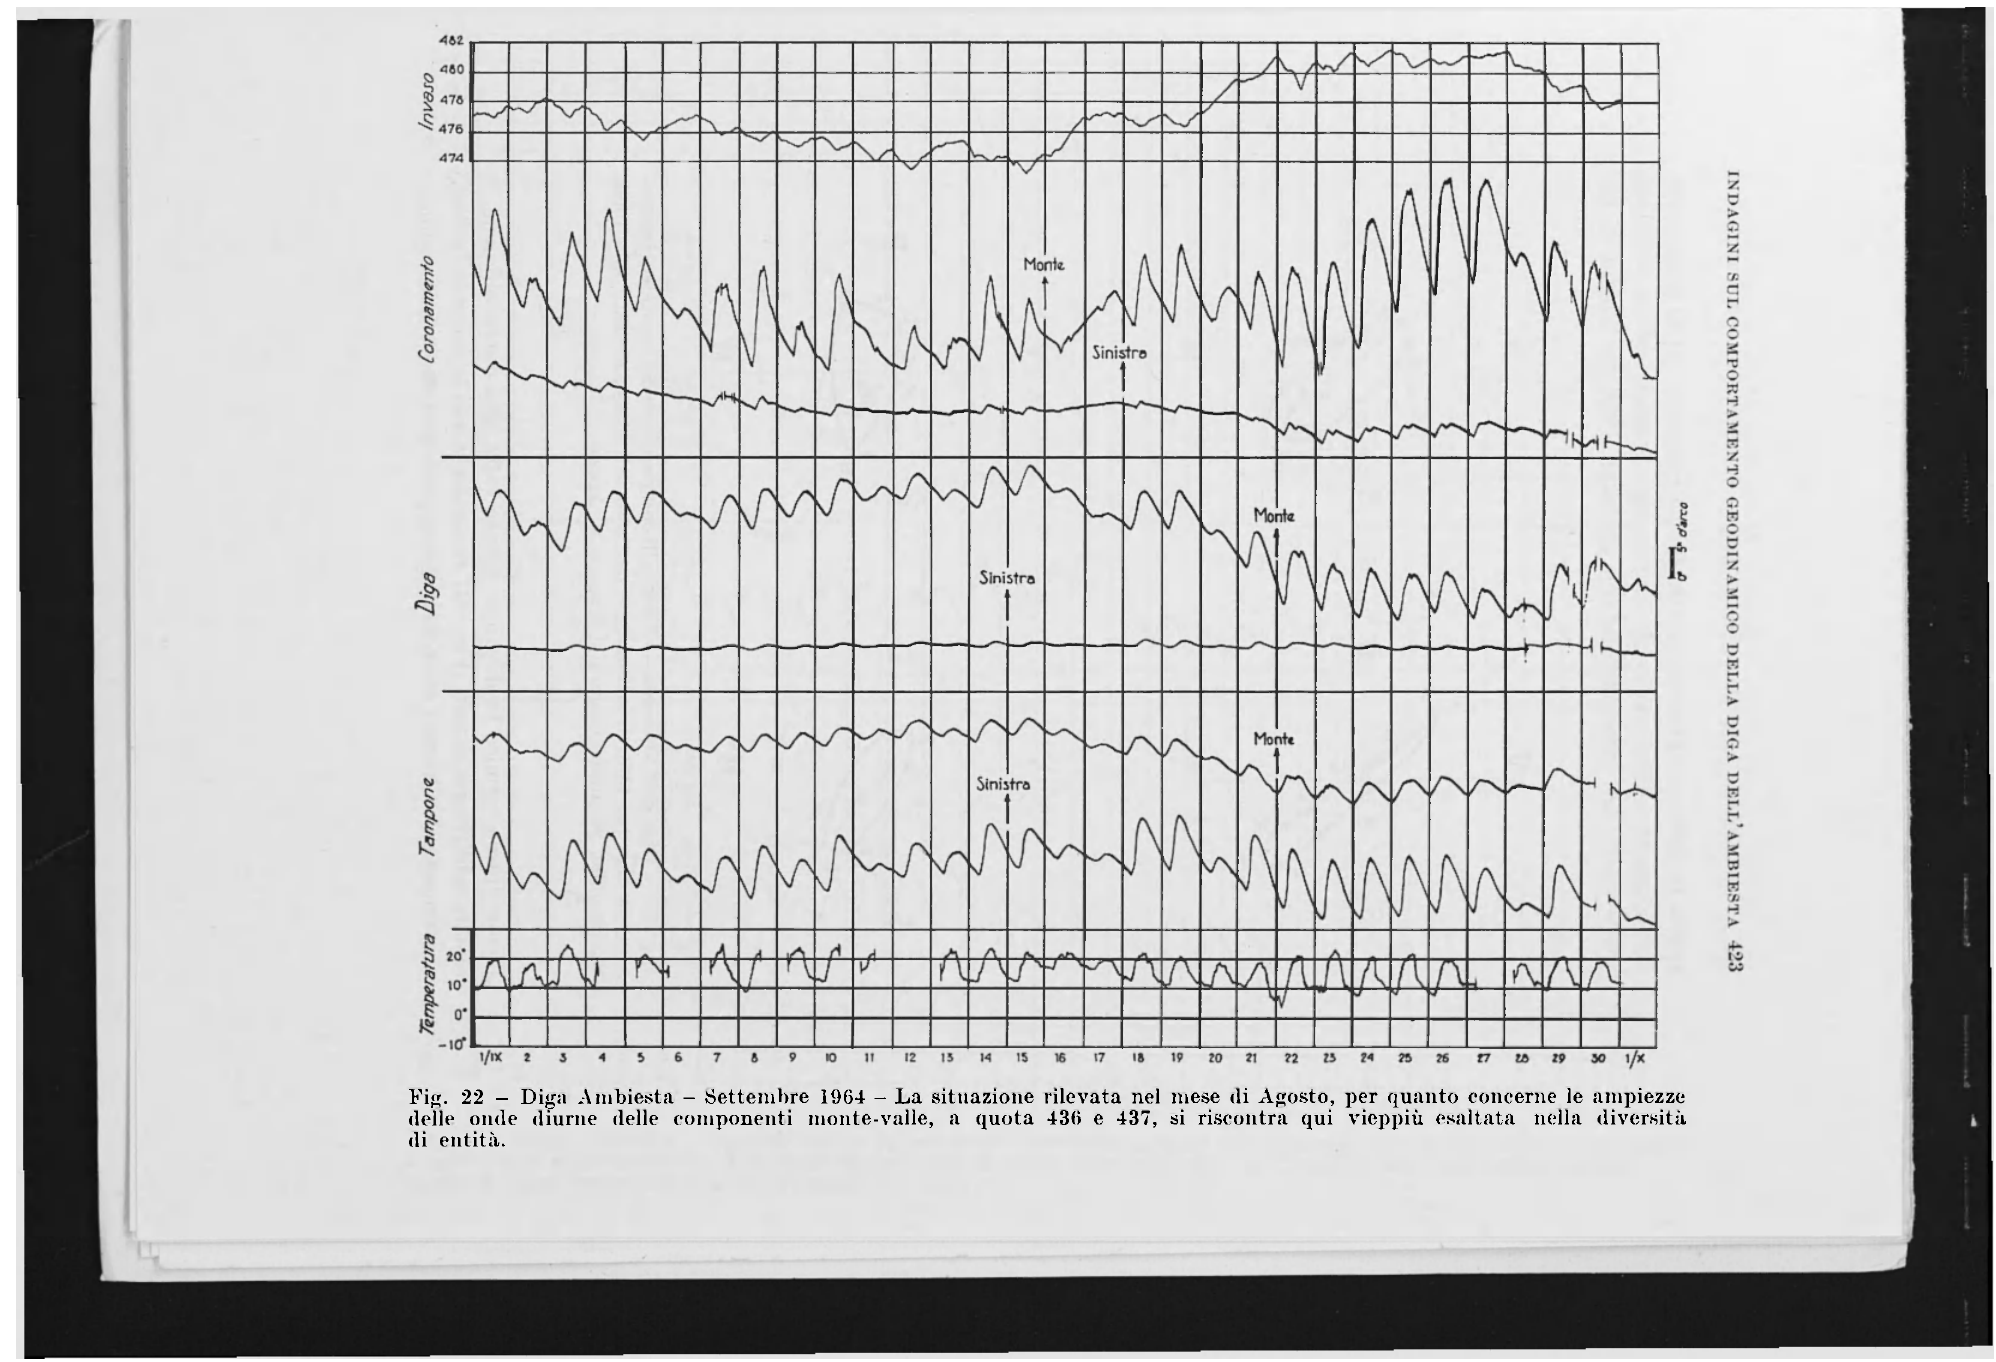
Fig. 22 - Diga Ambiesta - Settembre 1964 - La situazione rilevata nel mese di Agosto, per quanto concerne le ampiezze delle onde diurne delle componenti monte-valle, a quota 436 e 437, si riscontra qui vieppiù esaltata nella diversità di